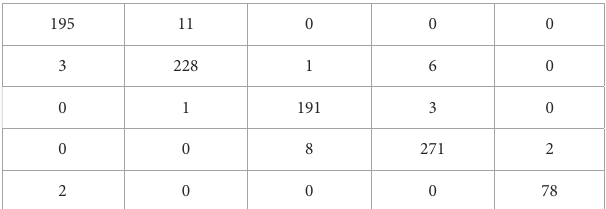
TABLE 7 Confusion matrix.